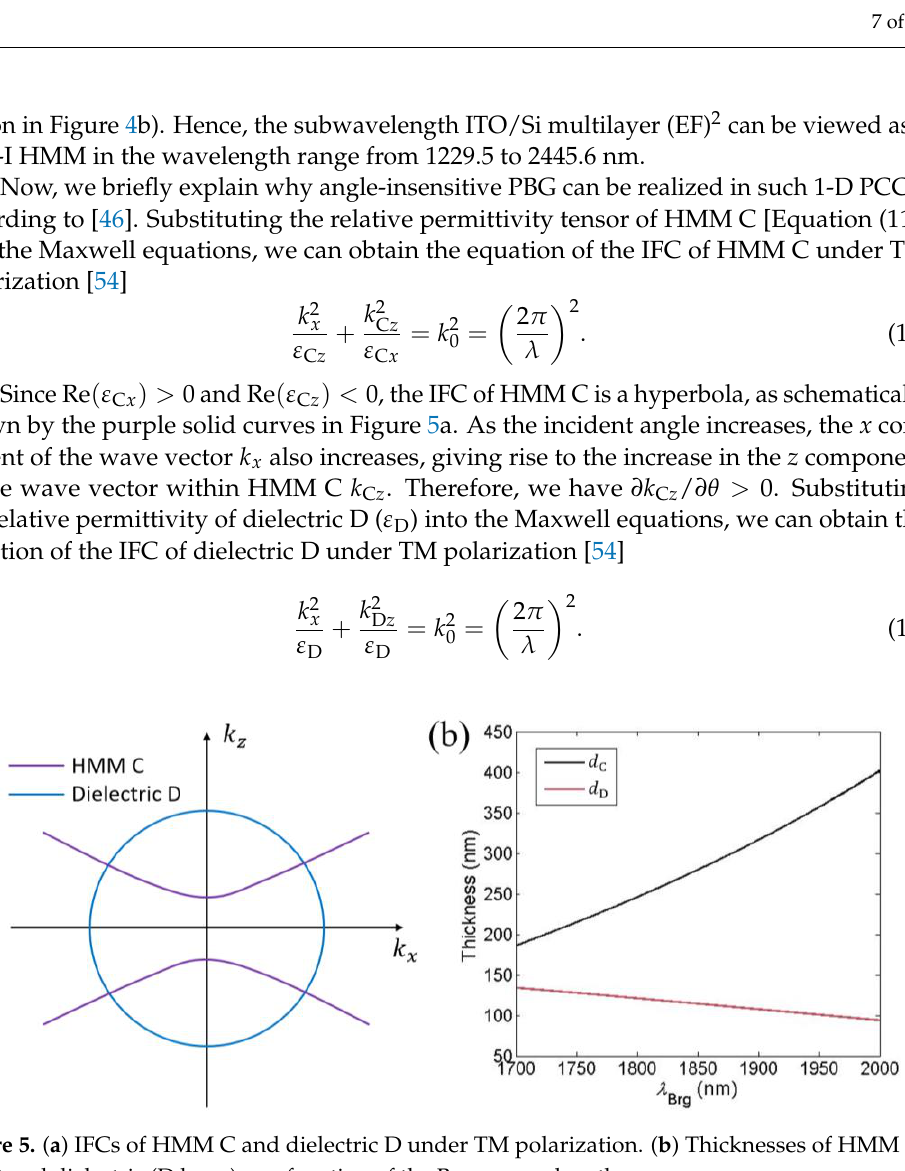
Figure 5. ( a ) IFCs of HMM C and dielectric D under TM polarization. ( b ) Thicknesses of HMM (C layer) and dielectric (D layer) as a function of the Bragg wavelength.